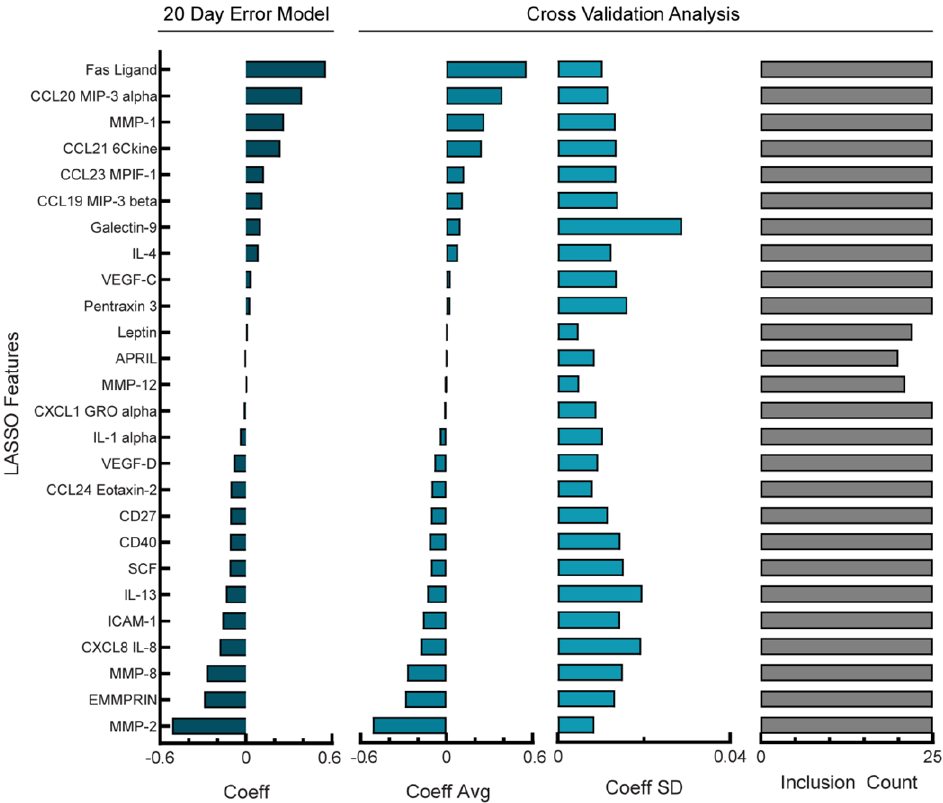
Figure 3. Reduction in features used in NACT model produces a more robust model. Lasso coefficient values and cross-validation error analysis for NACT model with RMSE = 18.6 days. Cross-validation analysis includes average coefficient values, standard deviation, and count of inclusion for the features retained in the full model across the 24 leave-one-out cross-validation folds. Positive coefficients correspond to longer PFI.